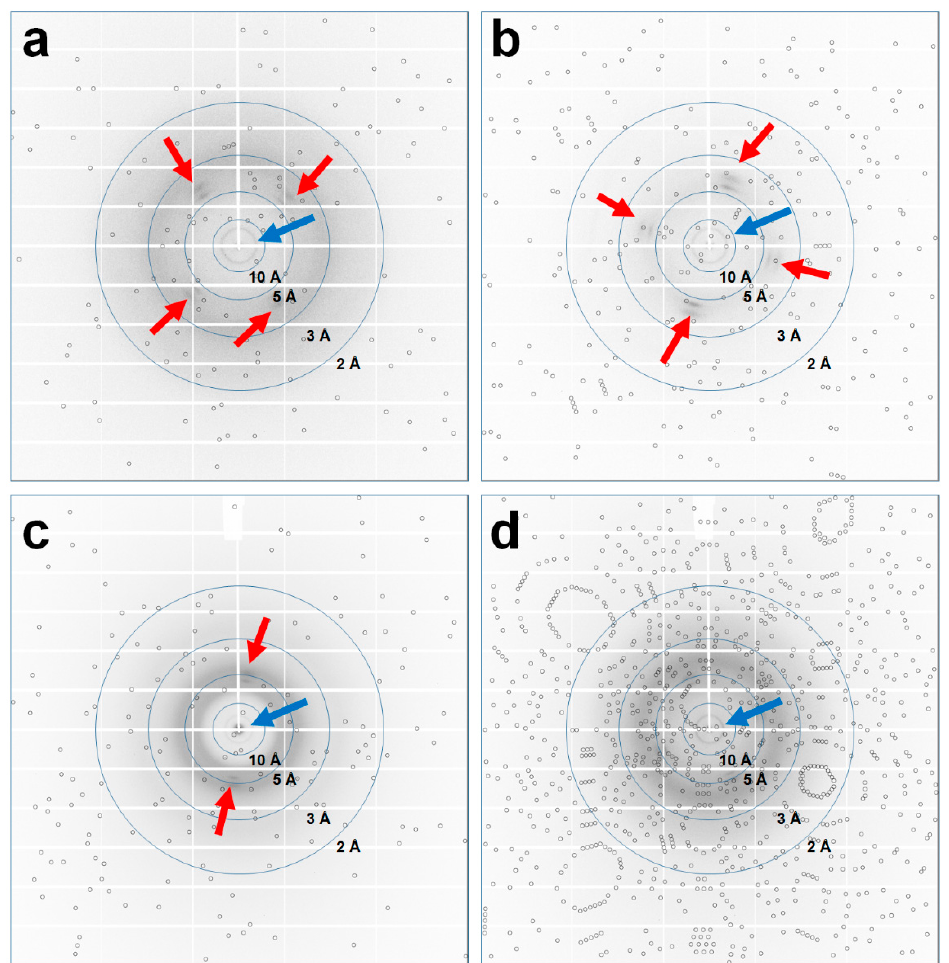
Figure 3. Typical diffraction patterns of ( a ) lysozyme (X-ray exposure time: 100 ms/oscillation: 0.011°, ( b ) glucose isomerase (100 ms/0.011°), ( c ) lysozyme (500 ms/0.222°), and ( d ) glucose isomerase (500 ms/0.222°) delivered to NAM-based sample holder. The circles indicate the predicted locations of Bragg peaks by CrystFEL. X-ray scattering from nylon-mesh and polyimide film is indicated by red and blue arrows, respectively. Image of nylon X-ray scattering when synchrotron X-ray penetrates ( a , b ) nylon intersection, ( c ) nylon, and ( d ) mesh pore.